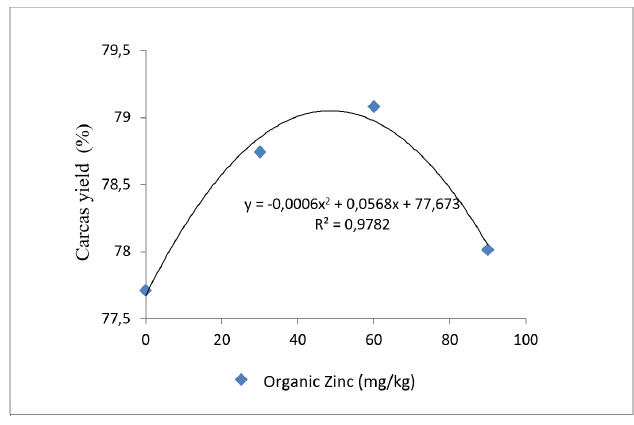
Figure 1. Carcass yield of 21-day-old broilers fed organic zinc